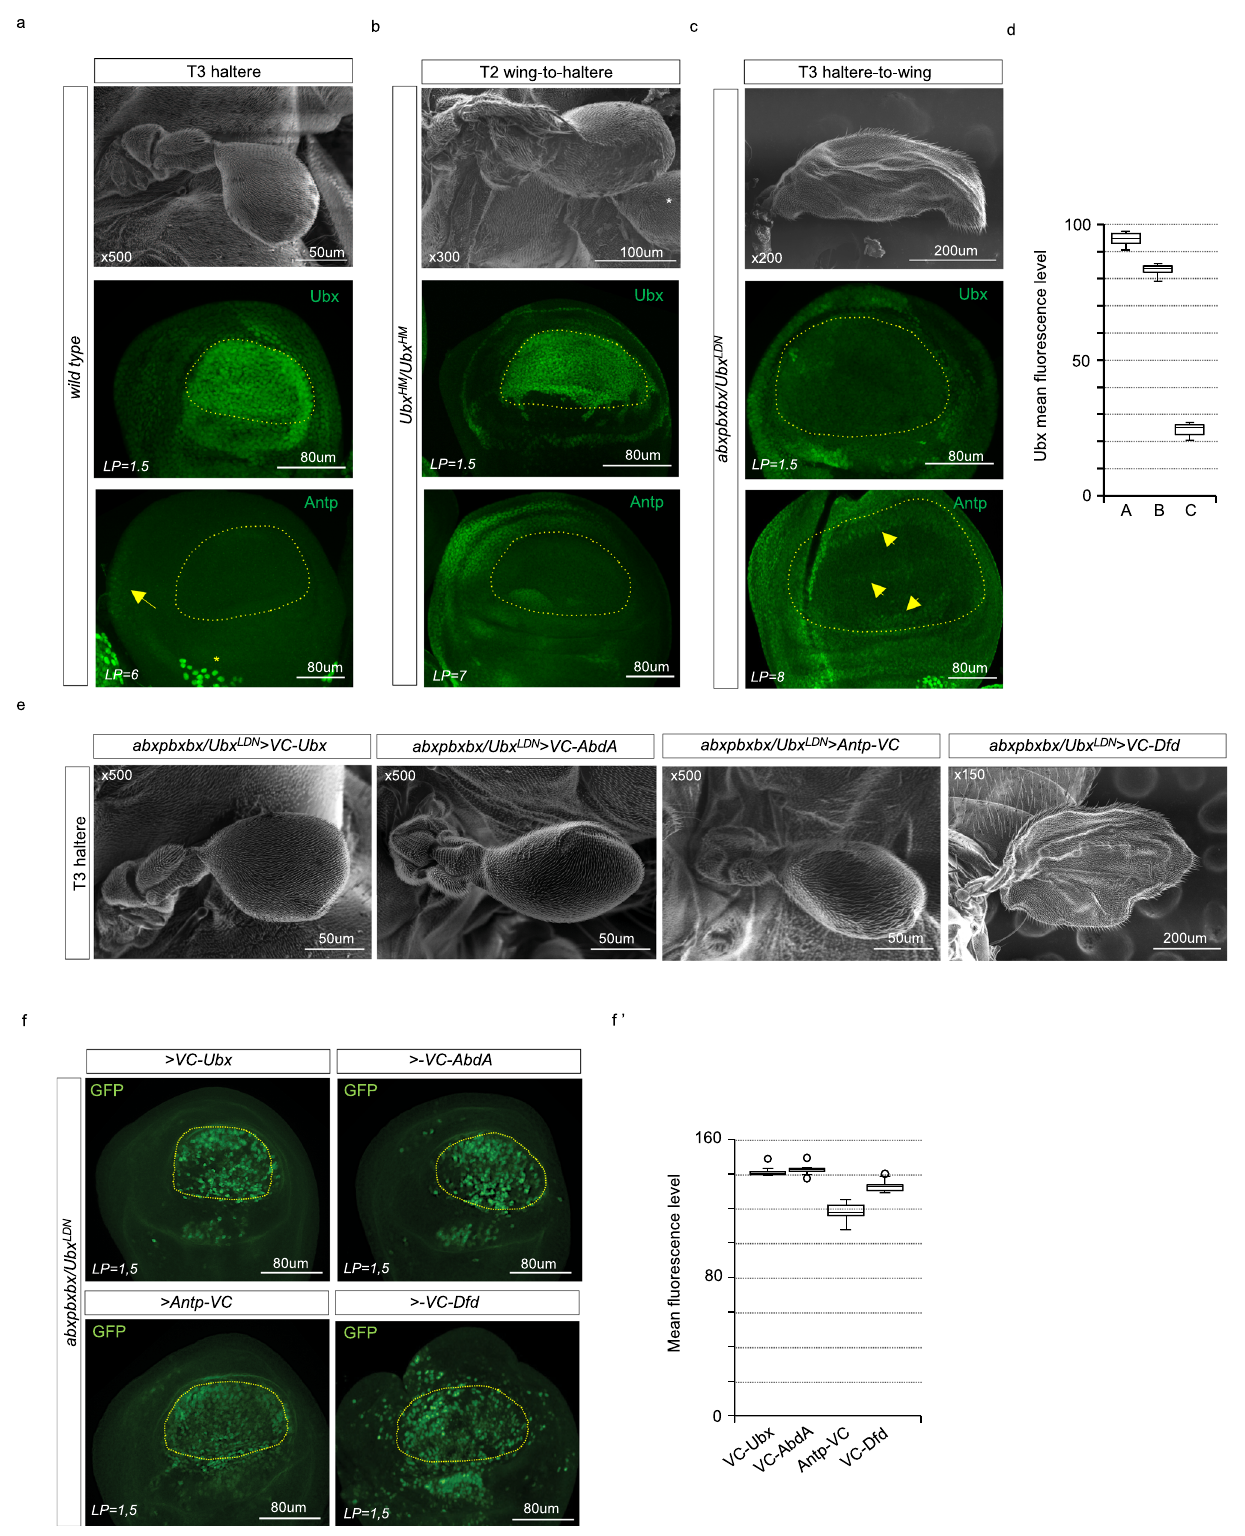
GGTTCTGATGGACCTGTGAT). The pCFD6-UAS-Antp-gRNAs construct was injected by BestGene (attP5, third chromosome) 33 . Primers and sequence maps are available upon request. The following GAL4, Gal80 ts , and UAS stocks were used: Ubx-GAL4 LDN 34 , Ubx HM 1 , abxpbxbx 34 , Nab-Gal4 (ref. 1 ), Dll-Gal4 (ref. 35